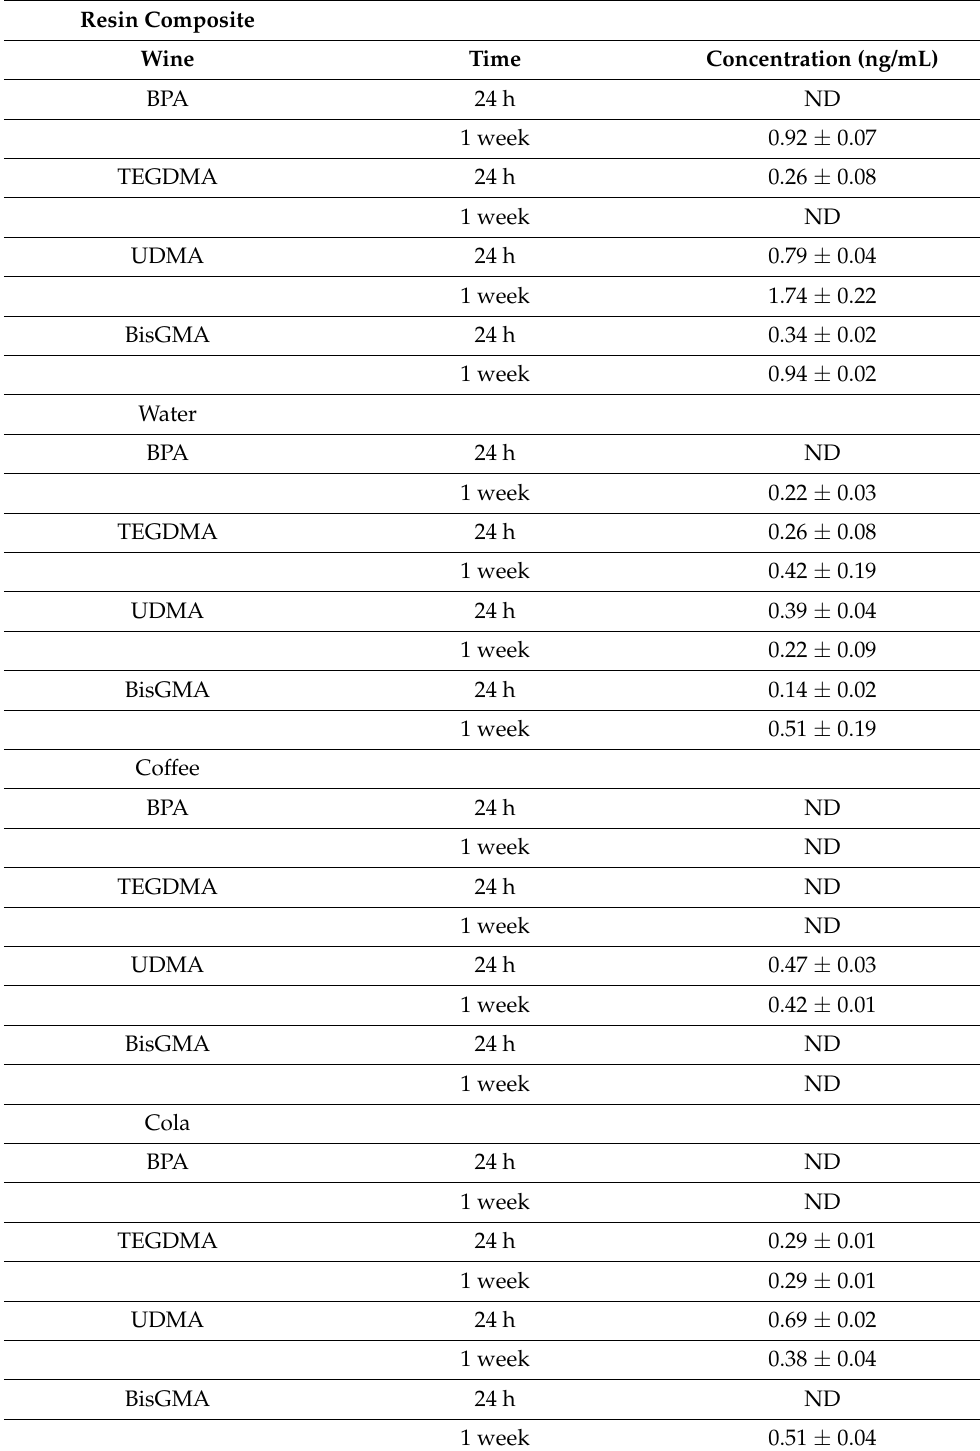
Table 5. Eluted impurities (Mean ± standard deviation, ng/mL) for resin composite after incubation in all beverage solutions and each time